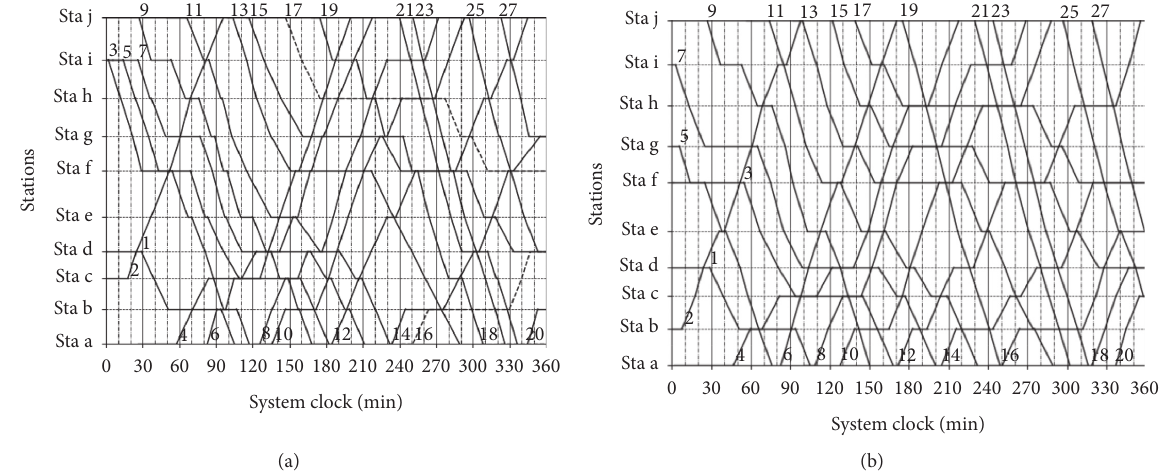
Figure 10: (a) The adequate train timetable of M.3 ; (b) the original train timetable in Figure 7.